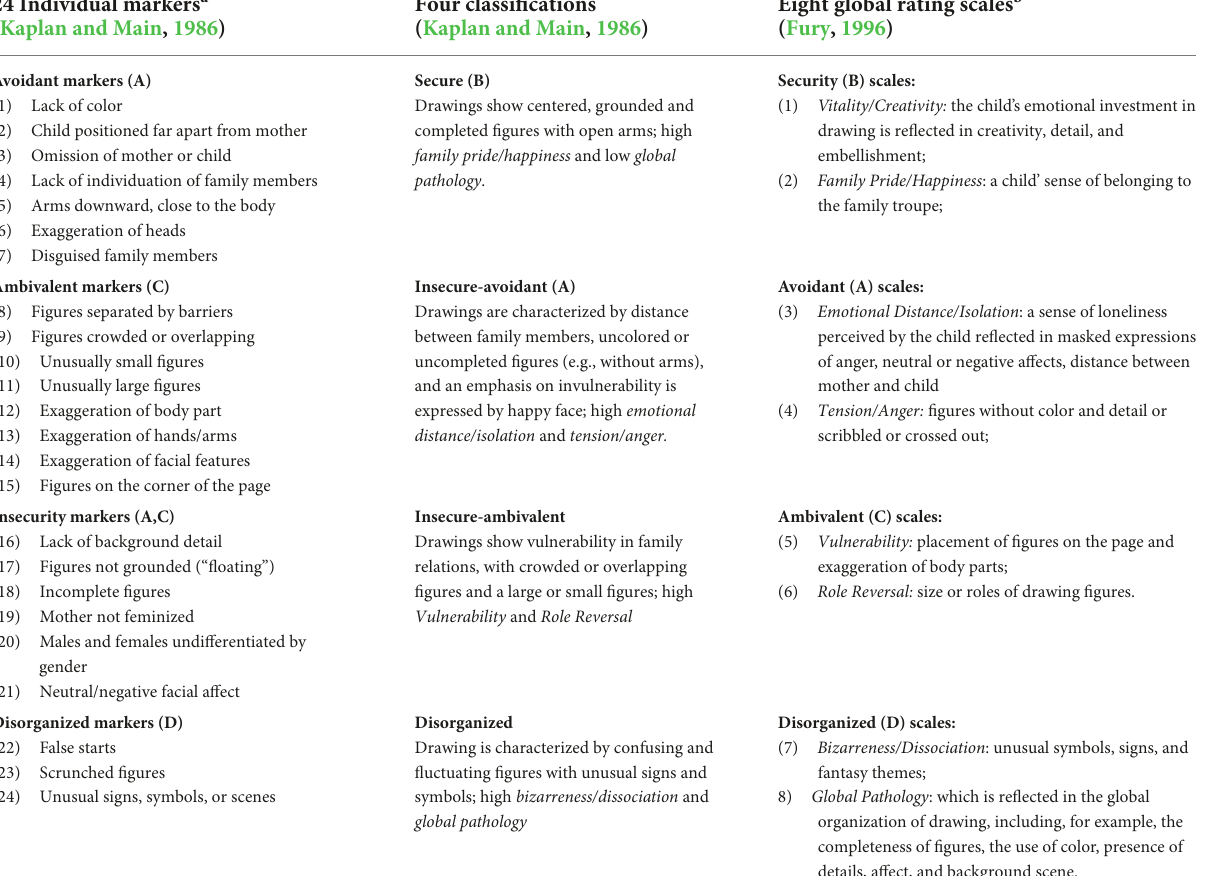
TABLE 1 Three levels of attachment-based coding system on Family